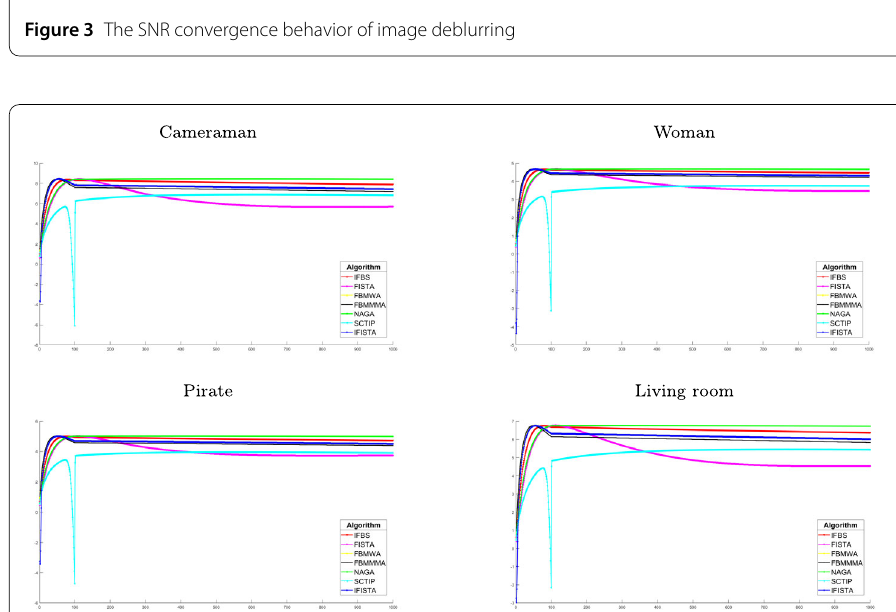
Figure 4 The ISNR convergence behavior of image